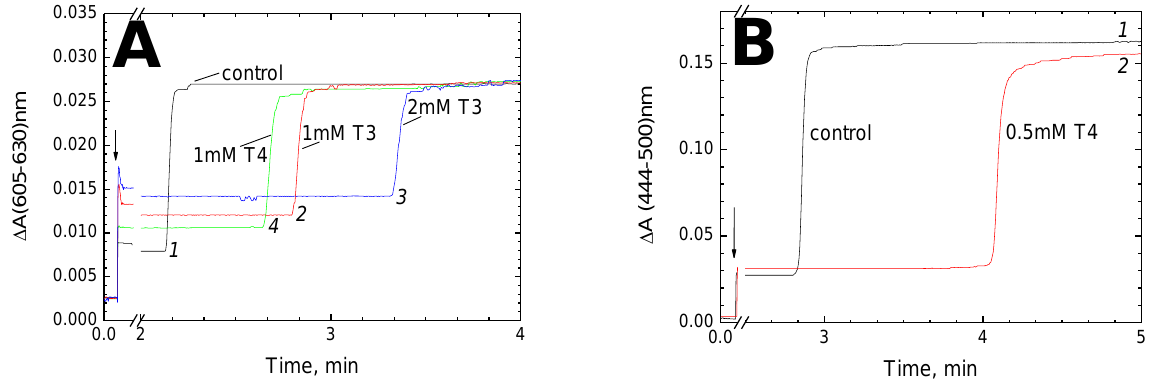
Figure 3. Hormones T3 and T4 decelerate electron transfer from heme a to heme a 3 . ( A ) Effect of T3 and T4 on the steady-state level of heme a reduction. CcO ( ca . 1 µ M) in the basic medium pH 8.0 supplied with 5 µ M RuAm, and where indicated, T3 or T4 was placed in a closed cuvette and reduced by addition of 5 mM ascorbate (indicated by the arrow). The reduction level of heme a was followed in the absence (control trace 1 , black) or presence of 1 mM T3 (trace 2 , red), 2 mM T3 (trace 3 , blue) or 1 mM T4 (trace 4 , green). ( B ) Effect of T4 on the kinetics of the reduction of hemes a and a 3 on the onset of anaerobiosis. The total reduction level of hemes a and a 3 was registered. Trace 1 , black=control and trace 2 , red=reduction of the sample in the presence of 0.5 mM T4. The other conditions were as in panel ( A ) except that 0.1 mM TMPD was used instead of RuAm. Panel ( A ) presents the kinetics of absorption growth at 605 nm relative to 630 nm ( α -absorption band with a contribution of heme a of about 80% [28]). The injection of the respiratory substrate (shown by an arrow) results in an instant increase of absorption up to a steady-state level of heme a reduction in the turning-over CcO. After 2 – 3 min, the reduction sharply rises to 100% due to the depletion of oxygen. It can be seen that in the presence of T3 (1 mM, red curve 2 , or 2 mM, blue curve 3 ) or T4 (1 mM, green curve 4 ) anaerobiosis occurs later than in the control (black curve 1 ). This is explained by the inhibitor slowing down the enzyme activity. Notably, the inhibitory effect of mones on CcO does not require the presence of cytochrome c and is also manifested in the